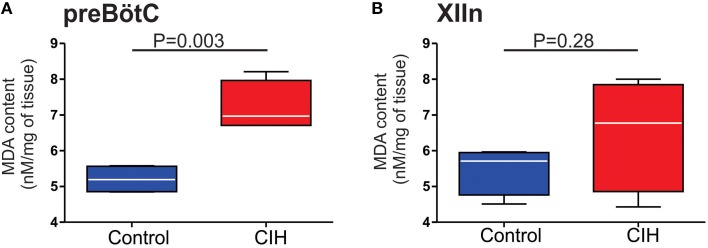
Effect of CIH on the degree of lipid peroxidation in the preBötC and XIIn. Summarized MDA content measured in tissue homogenates from (A) the preBötC (n = 4 samples) and (B) XIIn (n = 4 samples).